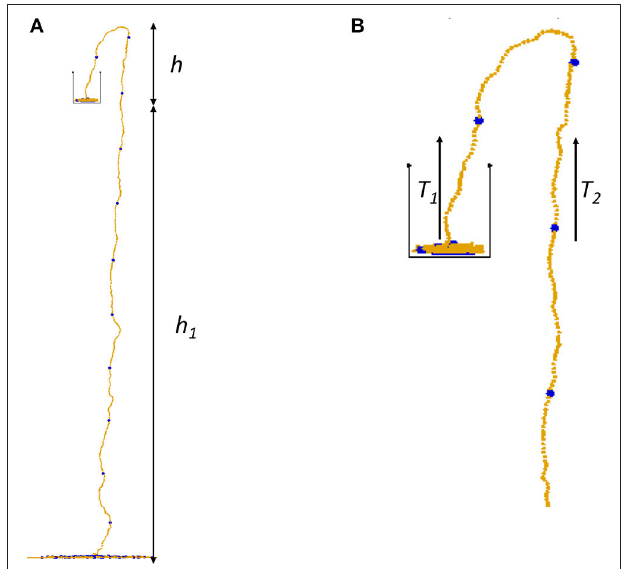
FIGURE 1 | (A) A snapshot from a simulation of the chain fountain with (B) a T 2 are at the same height. Larger blue beads are closeup. The tensions T 1 = introduced for visualization purposes only and have the same properties as the other